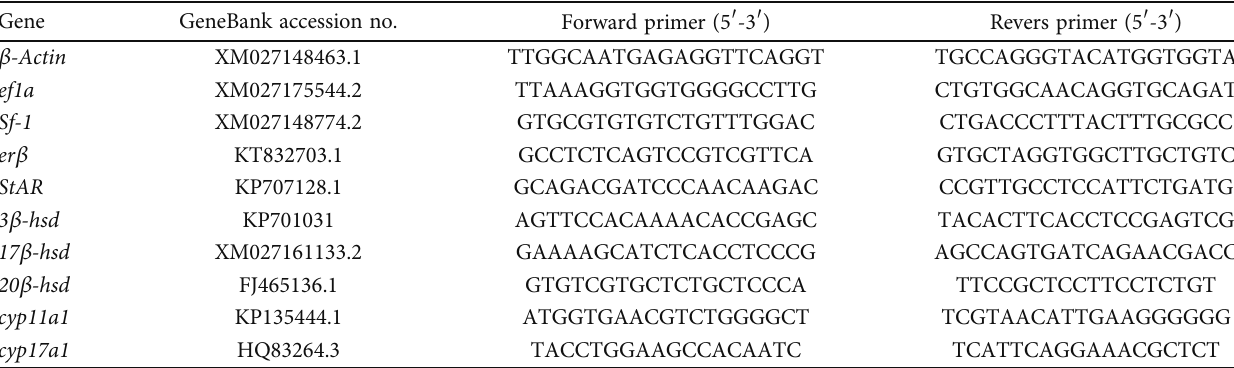
Table 4: Primers used in quantitative real-time PCR analysis.